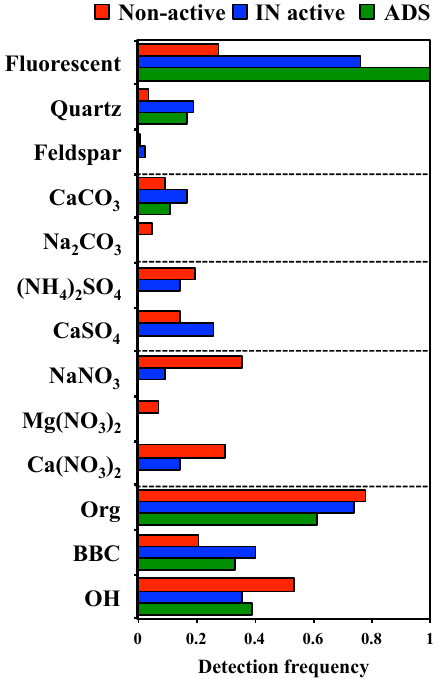
Figure 5. Summary of the detection frequencies of the assigned components in non-active and IN active particles by micro-Raman analysis. Data from ADS particles are shown for